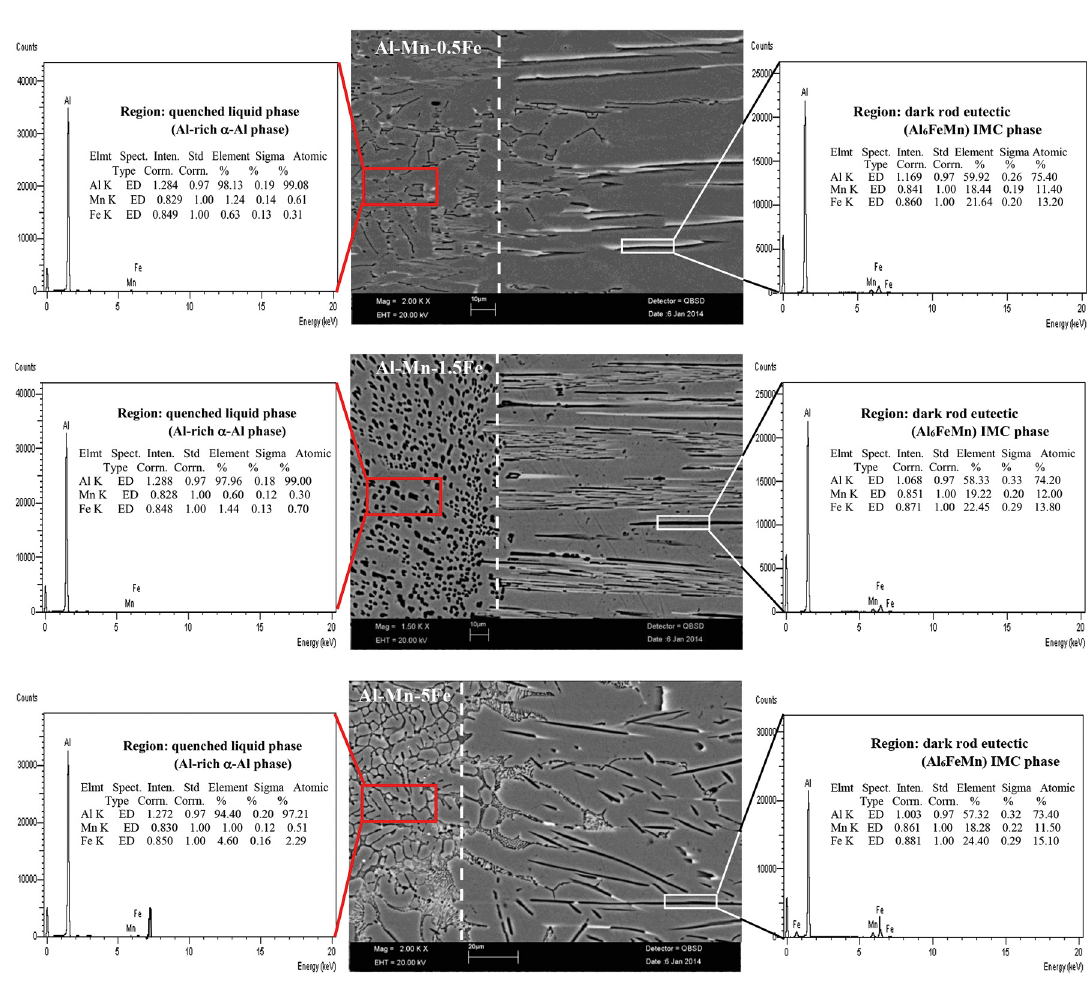
Figure 4. The chemical composition analysis of Al–1.9Mn–xFe ternary alloys by using SEM–EDX, dark rod eutectic phase (Al6MnFe intermetallics) and quenched liquid phase (Al-rich α-Al